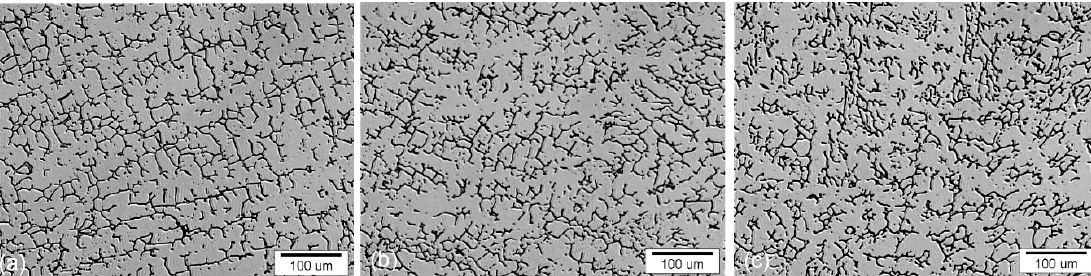
Figure 4. Optical micrographs of δ -ferrite in the as-cast microstructure. Locations are 3 mm ( a ), 10 mm from edge ( b ), and center of the ingot ( c ).